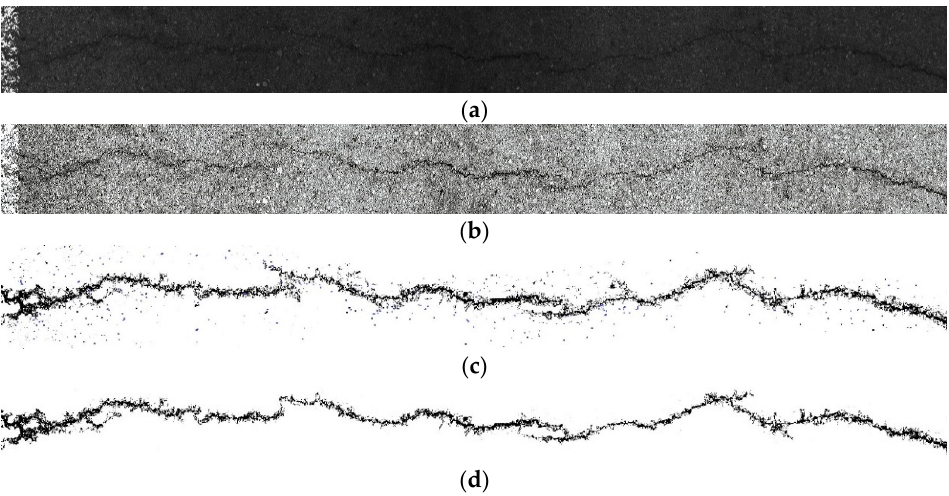
Figure 22. Comparative experiment of transverse crack segmentation. ( a ) original images, ( b ) image enhanced by guided filtering and Retinex method, ( c ) images generated by traditional k-means clustering algorithm, ( d ) ours.